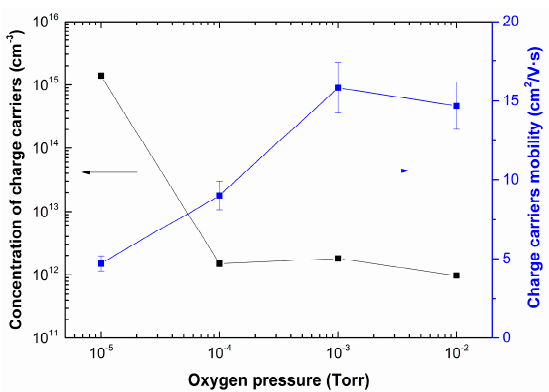
Figure 9. Dependences of concentration and charge carrier mobility of LiNbO 3 films grown by PLD as a function of oxygen pressure.